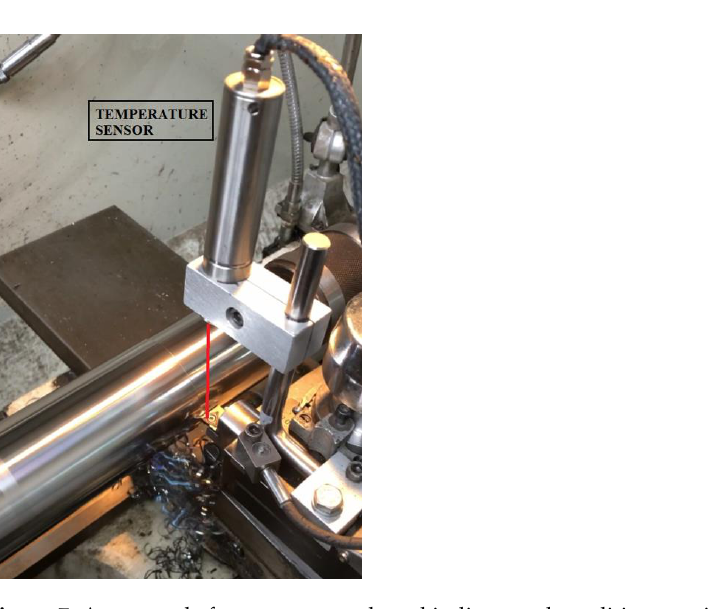
Figure 7. An example for temperature based indirect tool condition monitoring